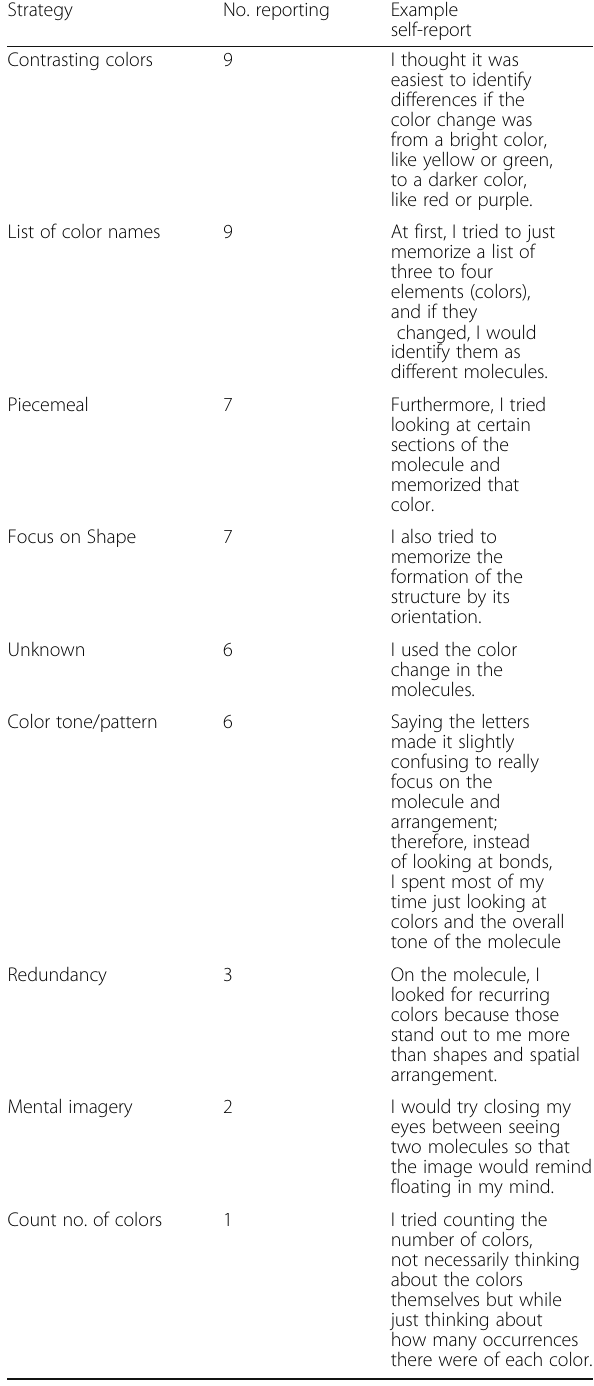
Table 2 List of strategies reported by participants Strategy No.